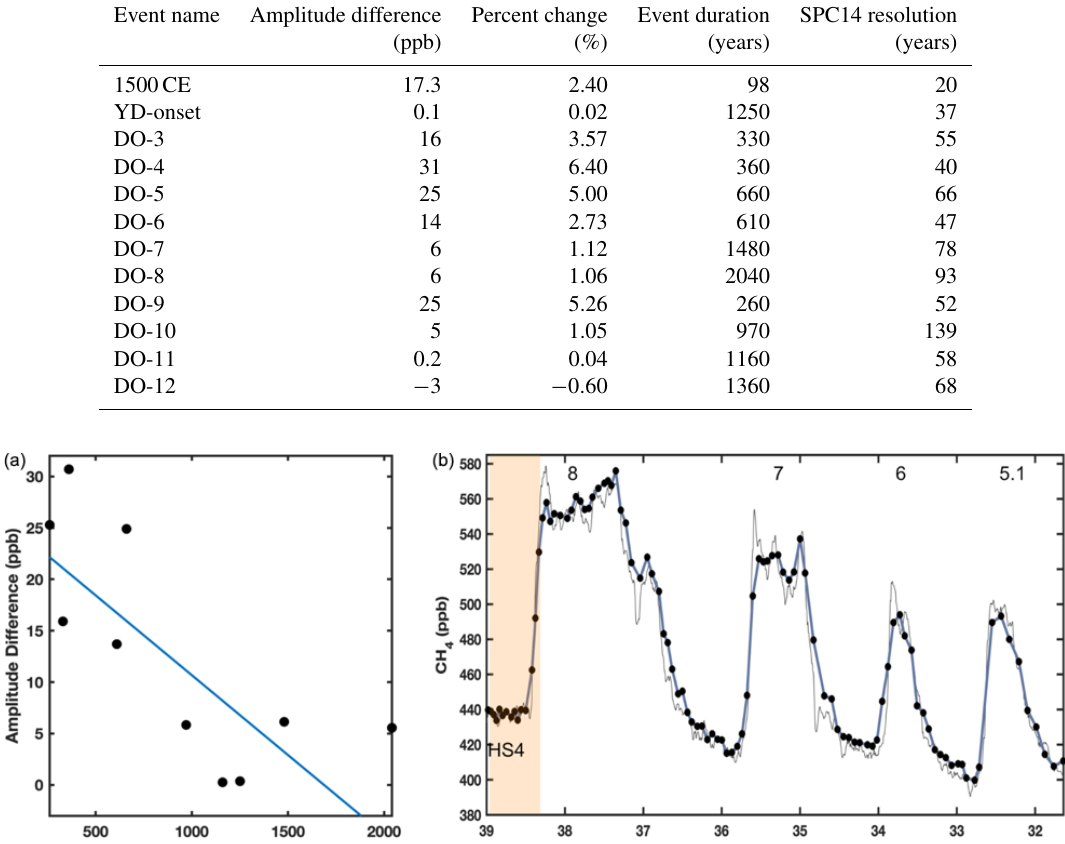
Figure 5. (a) Correlation of duration of event and amplitude difference between WD and SPC14 events shows a clear negative trend ( r = − 0 . 74, p = 0 . 006). Black markers correspond to events listed in Table 2. (b) Example of smoothing from MIS3 showing smoothing of small-scale features in SPC14 (blue) relative to WD (gray). D-O events are numbered; Heinrich Stadial 4 is shaded in